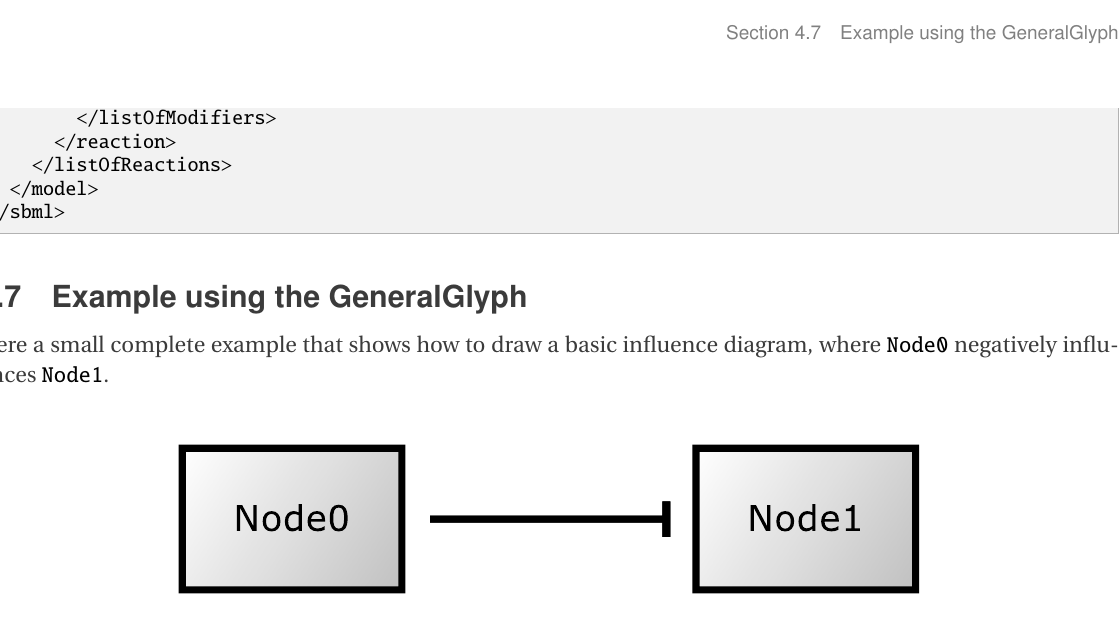
Figure 17: One possible rendering of an influence